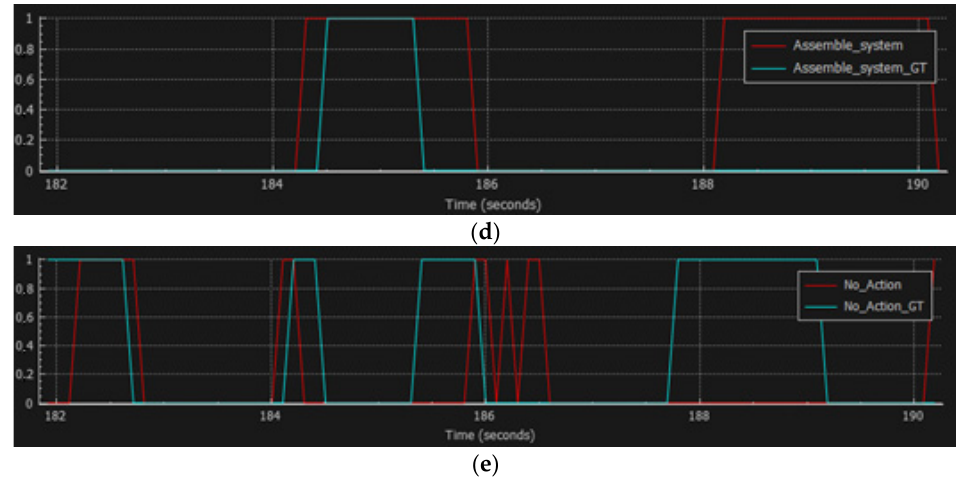
Figure 12. Online model performance results: ( a ) event plot for the Picking Left class; ( b ) event plot for the Picking Left class (second example); ( c ) event plot for the Picking In Front class; ( d ) event plot for the Assemble System class; ( e ) event plot for the No Action class.